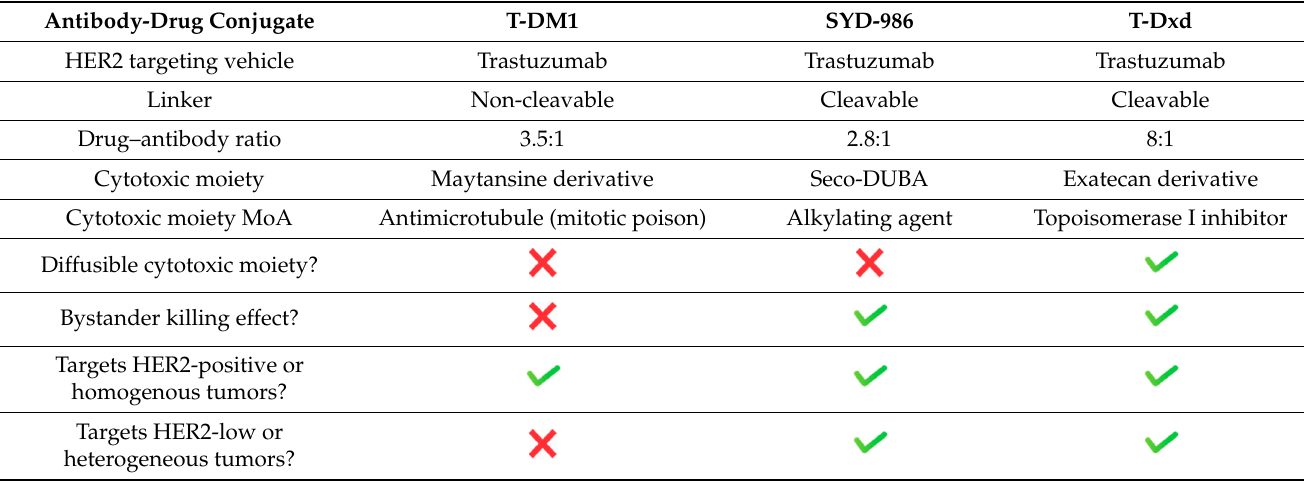
Legend: MoA = mechanism of action.